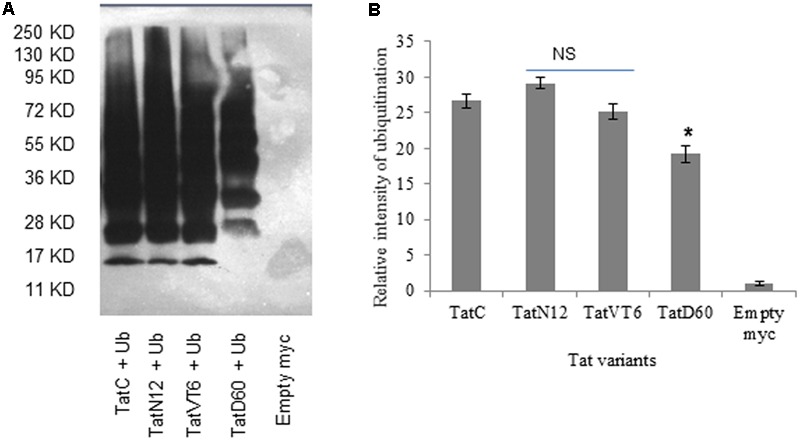
Ubiquitination of Tat variants. HEK293 cells were co-transfected with His6-Ubiquitin protein, and pCMV-myc Tat variants and wild-type TatC. After 24 h, cells were treated with MG132 (25 μM) for 8 h. Cell lysates were incubated with Ni-NTA beads and immunoblotted with anti-myc antibody. The relative intensity of Tat protein ubiquitination was measured using ImageJ software. Wild-type TatC was used as a reference Tat for comparison. Empty vector was used as a control. (A) Relative intensity of Tat proteins and wild-type Tat protein ubiquitination. (B) Quantification of Tat ubiquitination normalized to empty myc vector. Error bar represents the standard deviation in triplicates. Statistical comparison of each Tat variant to Tat C was calculated by one-way ANOVA with the Tukey’s test (∗ denotes P < 0.05 and NS denotes not significant).